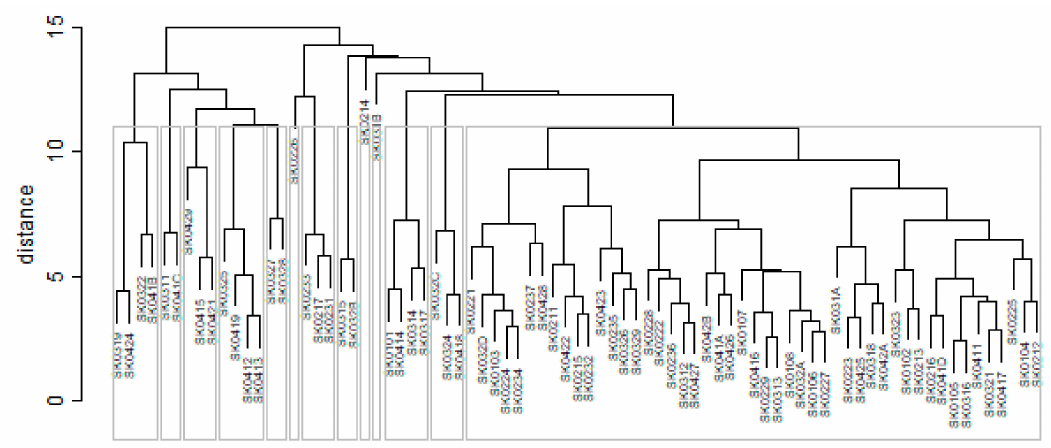
Figure 13. Preventable mortality dendrogram of the districts for the female sex in the year 2008. Source: own elaboration by the authors.